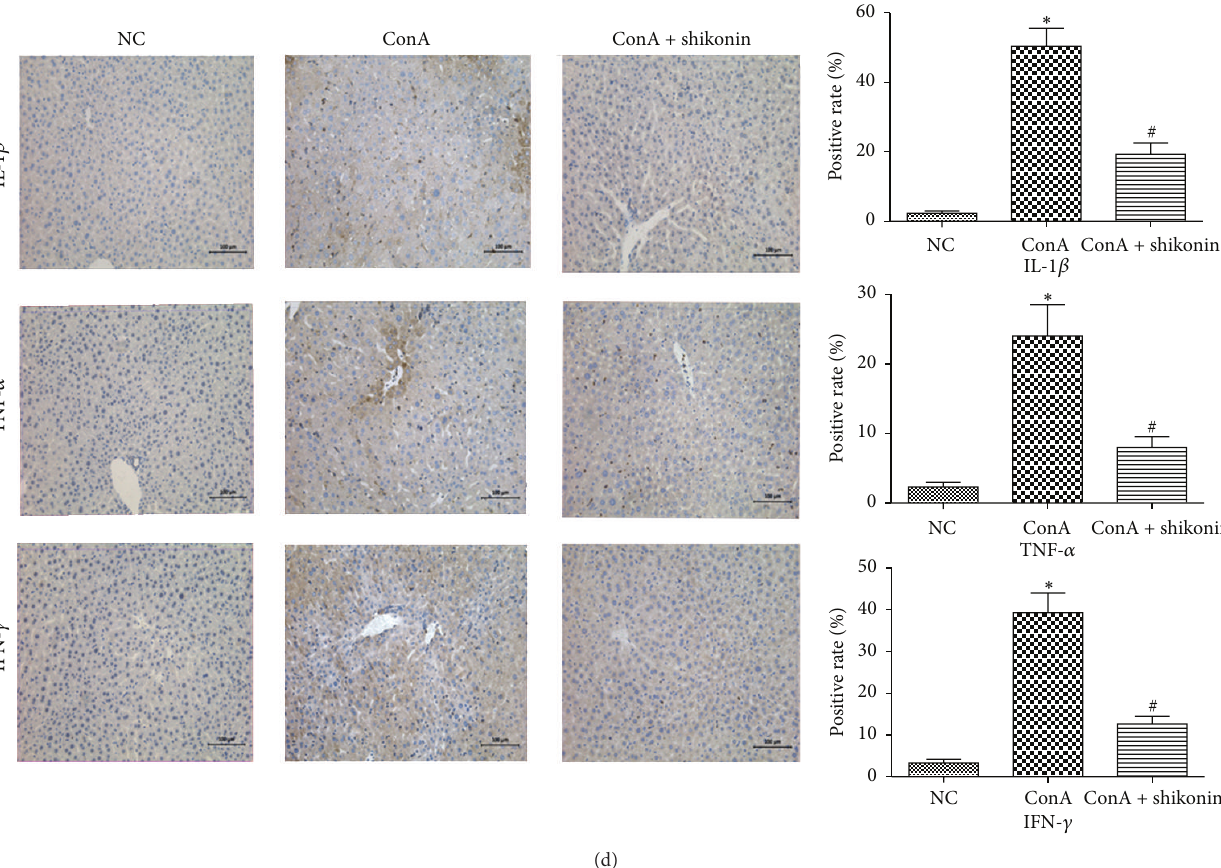
Figure 3: Effects of shikonin on the production of IL-1 𝛽 , TNF- 𝛼 , and IFN- 𝛾 in mice with ConA-induced acute hepatitis. (a) The levels of serum TNF- 𝛼 , IL-1 𝛽 , and IFN- 𝛾 , measured with ELISAs were reduced by shikonin pretreatment in mice at doses of both 7.5mg/kg and 12.5 mg/kg. Data are presented as means ± SD ( 𝑛 = 8 , ∗ 𝑃 < 0.05 for NC versus ConA, # 𝑃 < 0.05 for ConA + shikonin (7.5) versus ConA, and + 𝑃 < 0.05 for ConA + shikonin (12.5) versus ConA). (b) The mRNA levels of IL-1 𝛽 , TNF- 𝛼 , and IFN- 𝛾 were evaluated in each group with real-time PCR ( 𝑛 = 8 , ∗ 𝑃 < 0.05 for NC versus ConA, # 𝑃 < 0.05 for ConA + shikonin (7.5) versus ConA, and + 𝑃 < 0.05 for ConA + shikonin (12.5) versus ConA). (c) The expression levels of the IL-1 𝛽 , TNF- 𝛼 , and IFN- 𝛾 proteins were determined with western blotting and the gray values were calculated ( 𝑛 = 8 , ∗ 𝑃 < 0.05 for NC versus ConA, # 𝑃 < 0.05 for ConA + shikonin (7.5) versus ConA, and + 𝑃 < 0.05 for ConA + shikonin (12.5) versus ConA). (d) Immunohistochemistry staining ( × 200) showing the expression of IL-1 𝛽 , TNF- 𝛼 , and IFN- 𝛾 in liver tissue at 6 h. The ratio of brown area to total area was analyzed with Image-Pro Plus 6.0 ( 𝑛 = 8 , ∗ 𝑃 < 0.05 for NC versus ConA, # 𝑃 < 0.05 for ConA versus ConA +